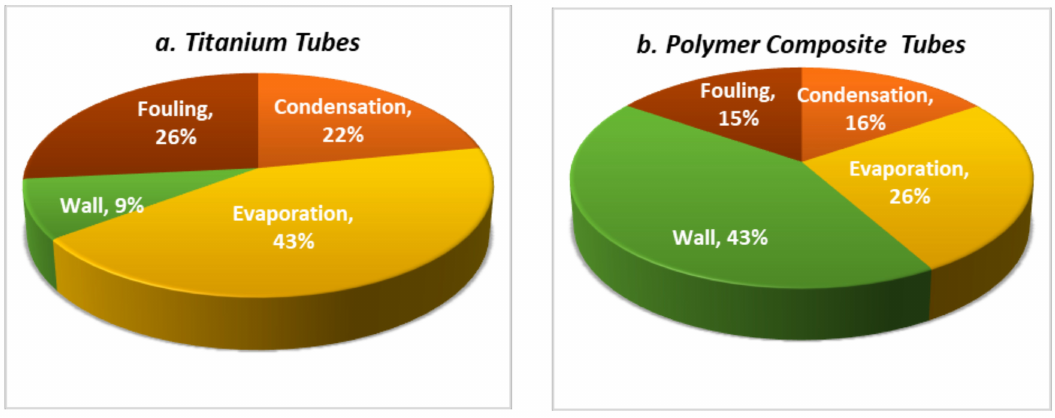
Figure 6. Thermal resistance distribution across the tube for ( a ) titanium and ( b ) polymer-G